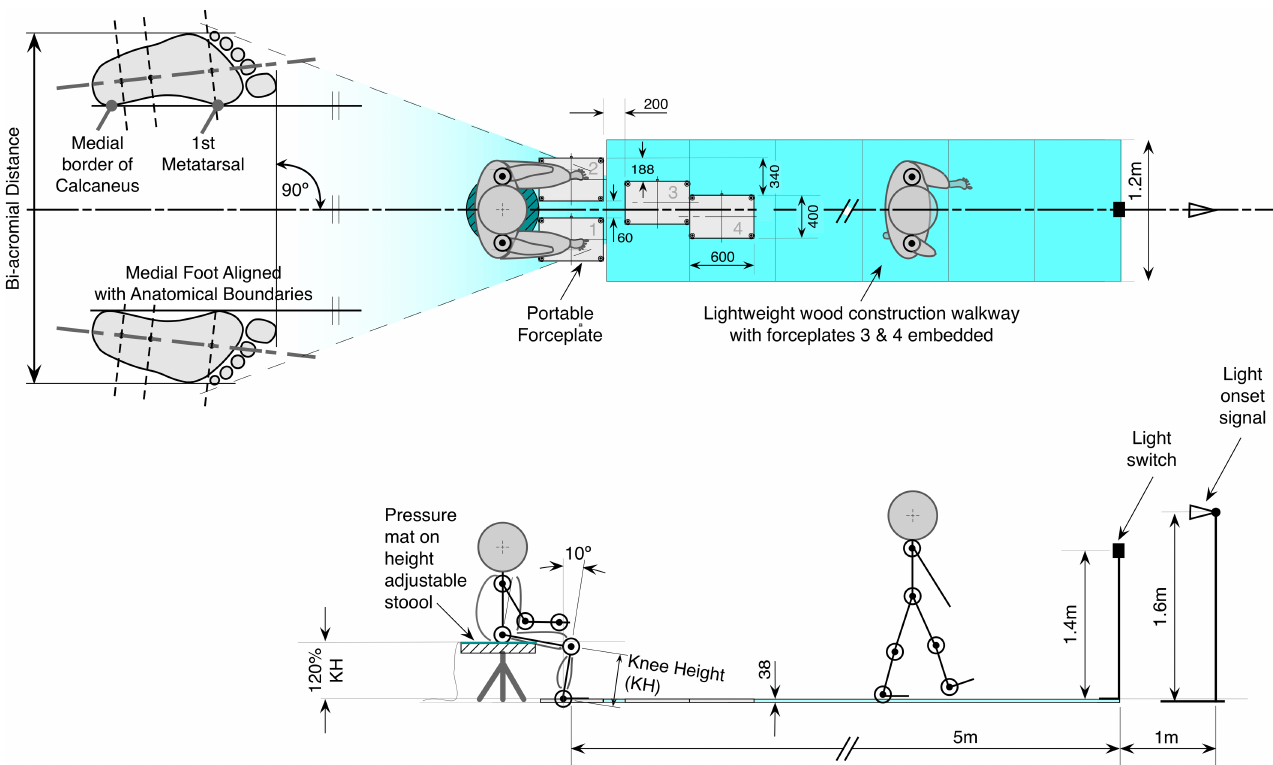
Fig 1. Experimental setup. This example shows a left-leg lead configuration: Participants sat on an instrumented stool at 120% knee height (KH), with ankles 10˚ in dorsiflexion, and feet at shoulder width apart orientated forward. In both STW and STSW task conditions on a light onset cue, participants rose with their feet on independent force plates, walked forward 5m over two further force plates embedded in the walkway with their arms unconstrained, and stopped to turn off the light at a switch. Participants performed 5 trials of each task leading with their non-dominant limb at self-selected pace. All dimensions in mm unless otherwise stated. Not to